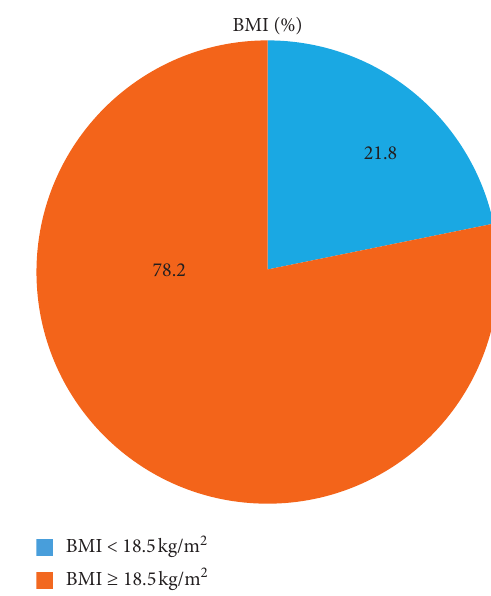
Figure 2: Nutritional status of lactating women in Dega Damot Woreda, Northwest Ethiopia, March-April 2018 ( n �